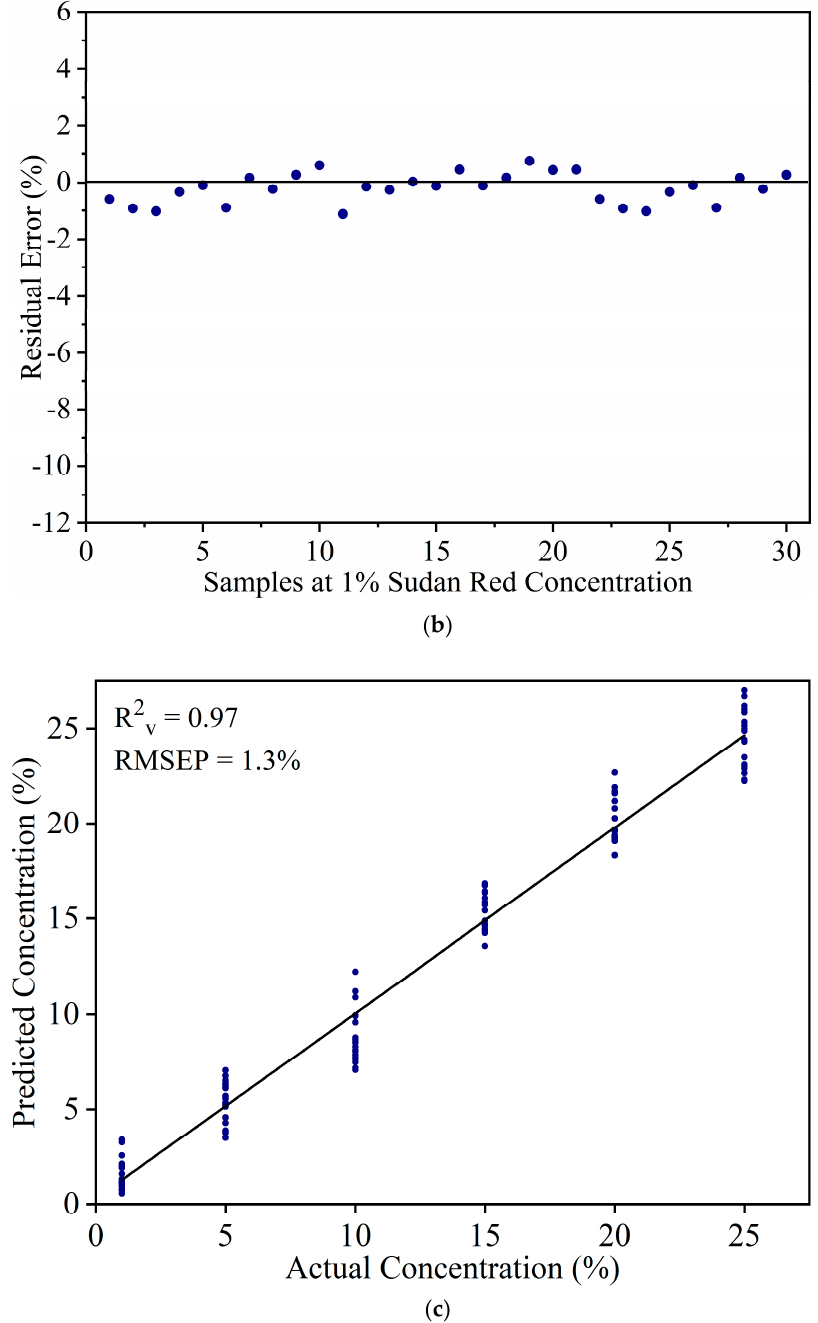
Figure 3. ( a ) Percentage variance explained by the number of PLS components. ( b ) Residual error of calibration set samples at 1% concentration. ( c ) Validation